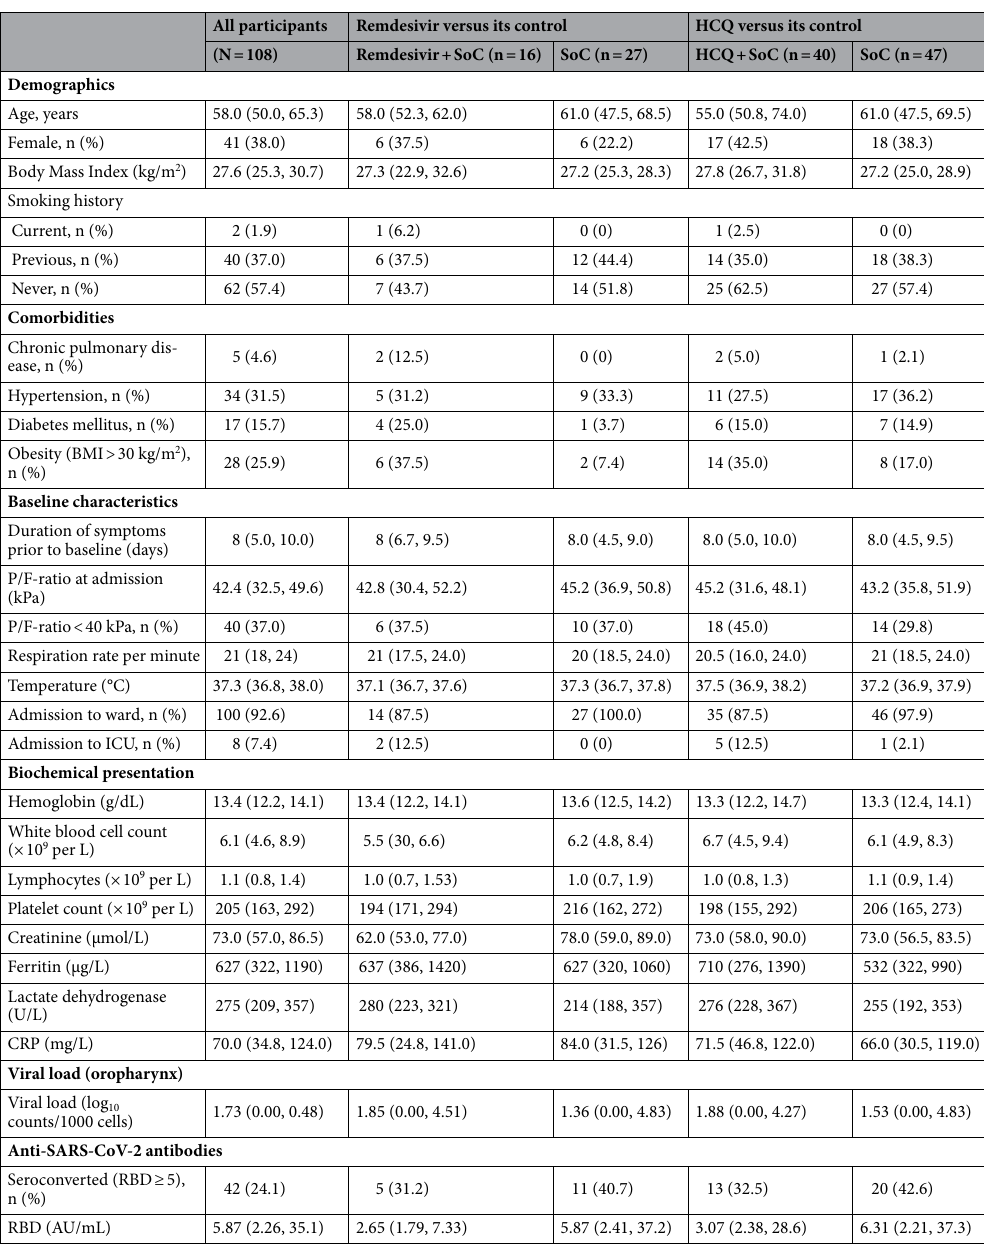
Table 1. Characteristics of population at baseline. Median values (25th–75th percentile) unless otherwise specified. HCQ hydroxychloroquine, SoC standard of care, ICU intensive care unit, P/F ratio arterial